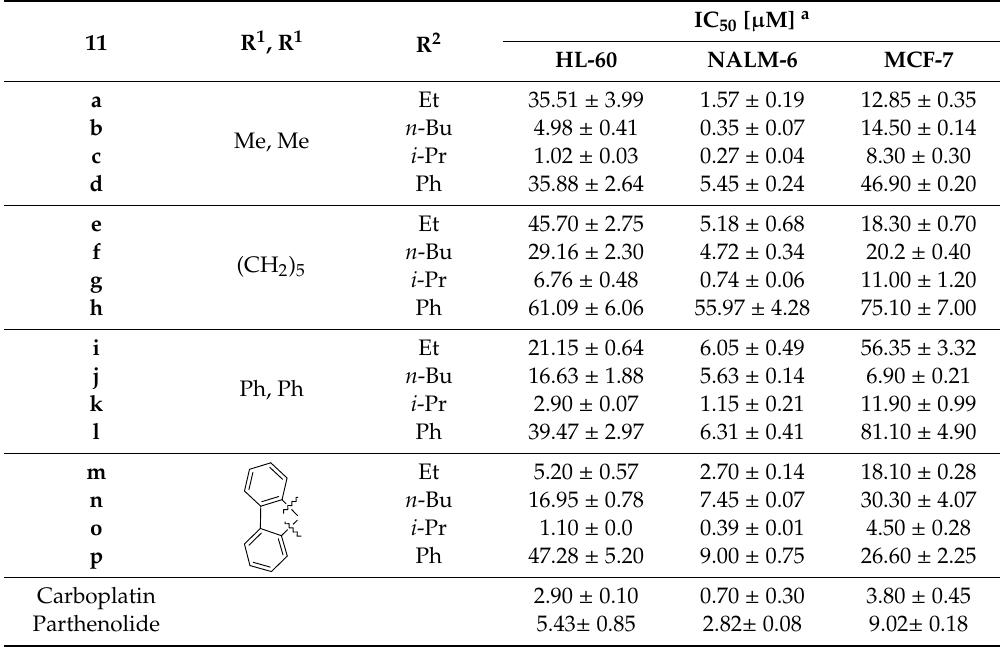
Table 3. In vitro cytotoxic activity of 5-methylidenetetrahydropyran-4-ones 11a – p tested on three cancer cell lines, HL-60, NALM-6, and MCF-7.